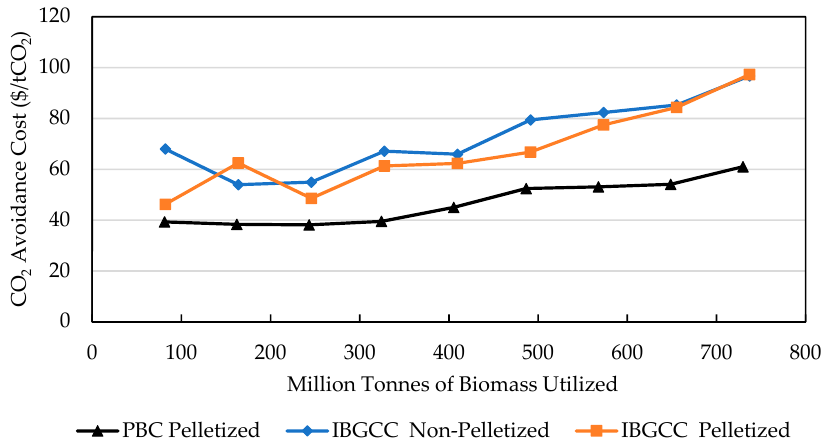
Figure 6. CO 2 avoidance cost (in $ per tonne of CO 2 avoided) of BECCS using a PBC power plant reference case without CCS fueled by pelletized corn stover.